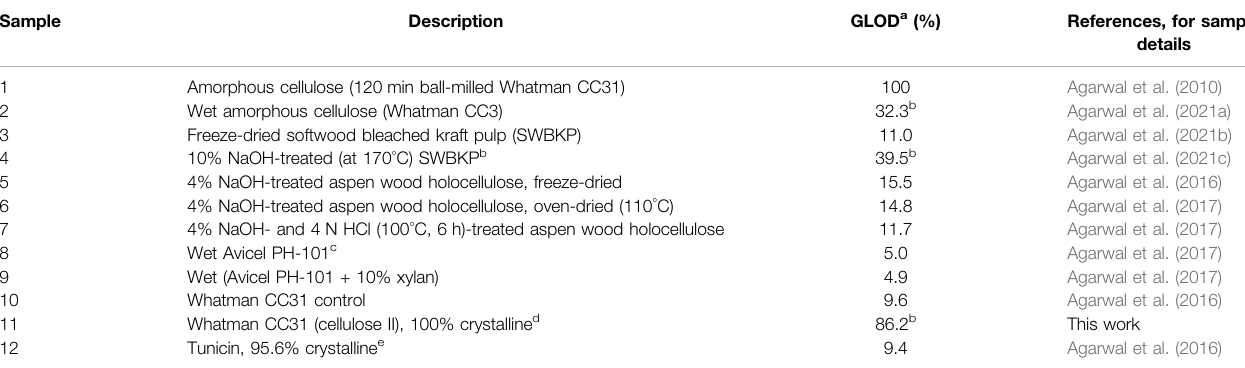
TABLE 4 | Glycosidic linkage orientation